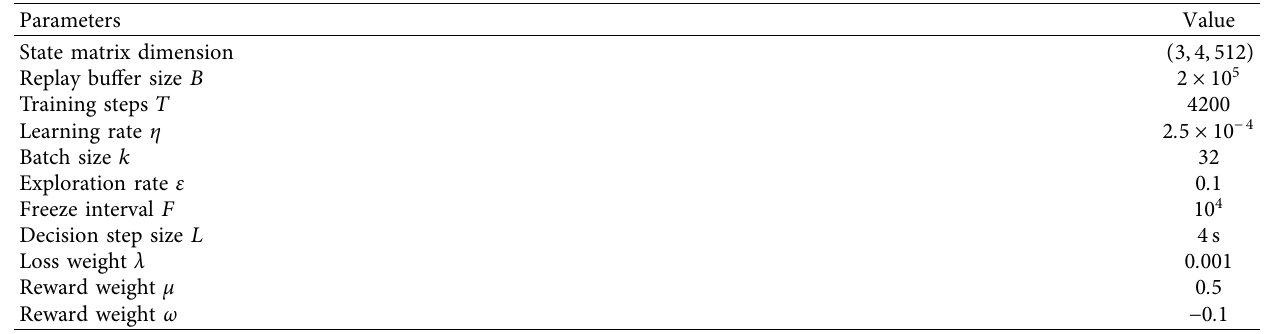
Table 1: Key parameters in deep Q-learning for ramp